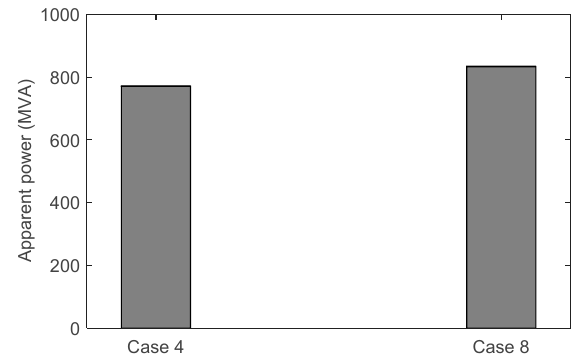
Figure 14. Imported total apparent power from main grid in Cases 4 and 8.